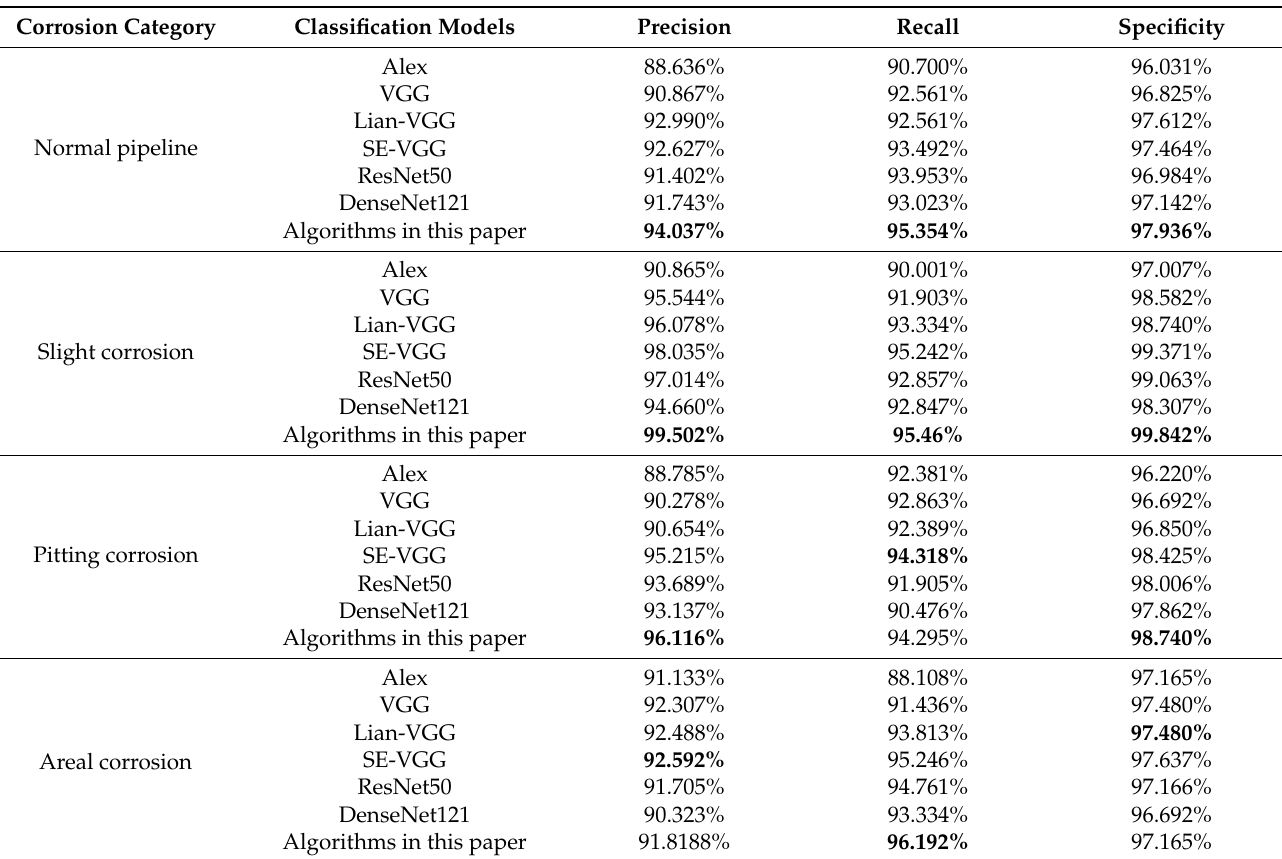
classification results of the Alex classification model, VGG classification model, Lian-VGG classification model, SE-VGG classification model, ResNet50 model, DenseNet121